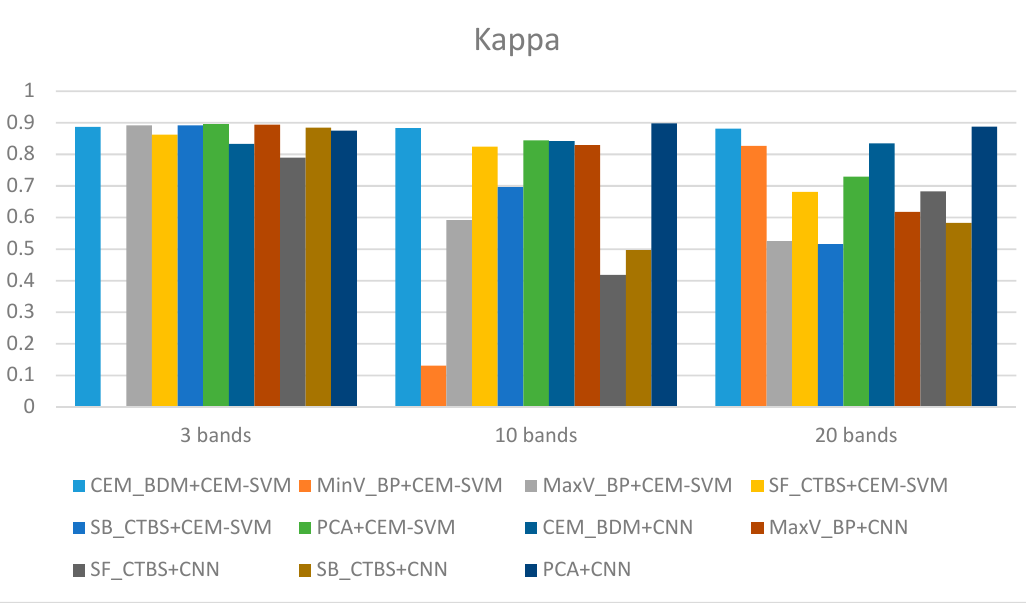
Figure 50. The Kappa histograms of 3 bands, 10 bands, and 20 bands.